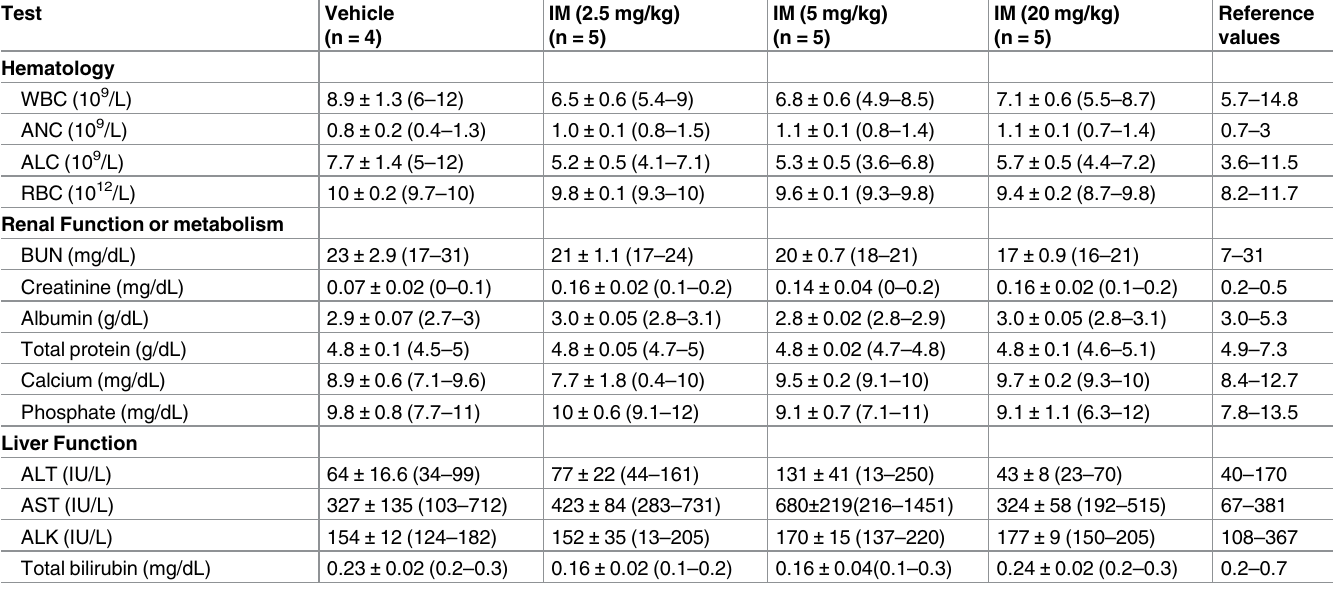
Table 1. Toxicity of IM a .